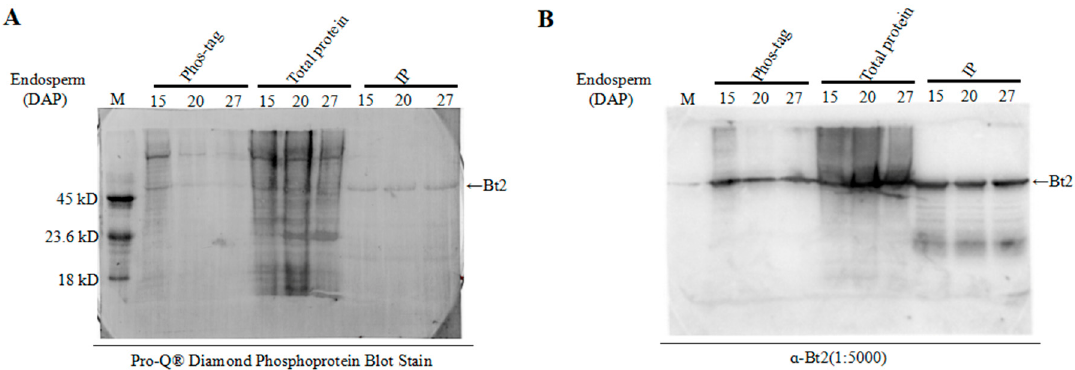
Figure 5. Detection of Bt2 phosphorylation proteins by Diamond Q staining technology. ( A ) Phosphoprotein Pro-Q staining of maize endosperm protein in indicated days after pollination; phos-tag TM group 200 µ g total protein was enriched by phos-tag TM agarose with maize endosperm protein; 20 µ g total protein was the control, and the IP group 200 µ g total protein was immunoprecipitated with the Bt2 antibody; M was a protein marker phosphorylated from Fisher Scientific Company. ( B ) The stained Bt2 protein band was demonstrated by immunoblot. Arrow